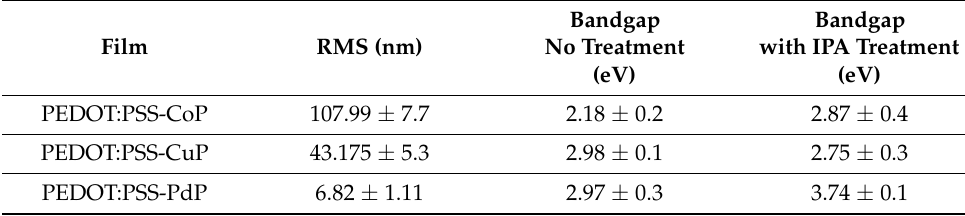
Table 2. RMS and bandgap for PEDOT:PSS-MP composite